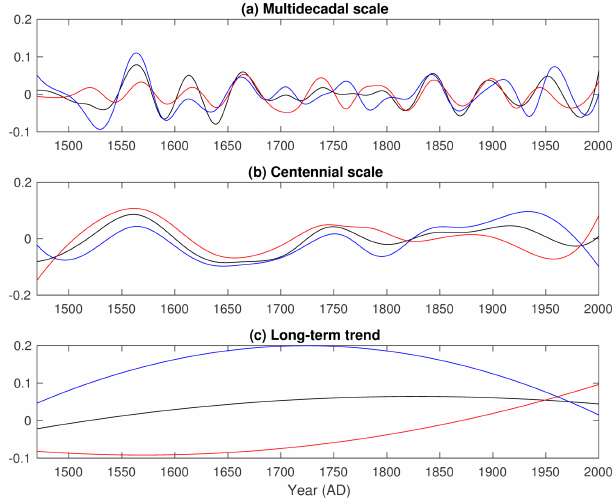
Figure 4. Comparison of the reconstructed (red line) and instru- mental MJJAS mean precipitation anomalies for China. The corre- lation coefficients are r = 0 . 89 ( n = 40, AD1961–2000) for instru- mental data (green line; Zhao et al., 2015), and r = 0 . 59 ( n = 41, AD1920–1960) for instrumental data (black line; Li et al., 2012).